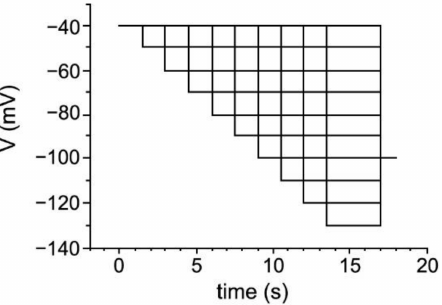
Figure 1. The pulse protocol for I h recordings in brain